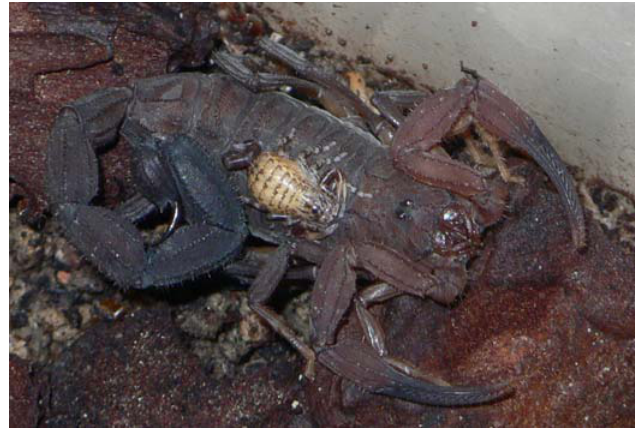
Figure 25. Female of Tityus sp. from ‘Pico da Neblina’ (Brazil / Venezuela) with parthenogenetic brood composed of a single